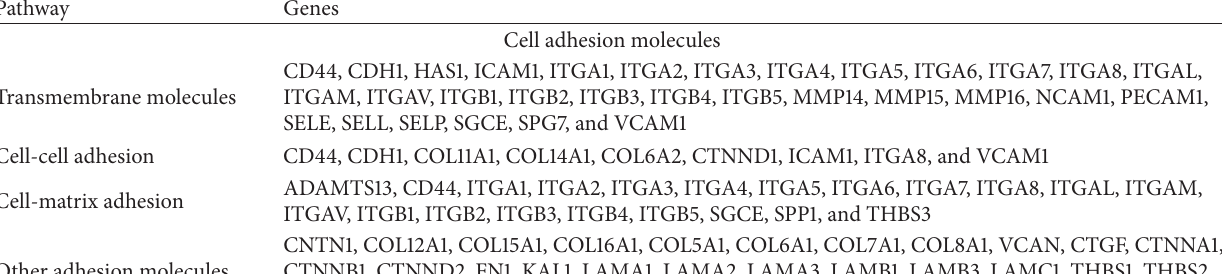
Table 2: Functional genes of the ECM and its adhesion